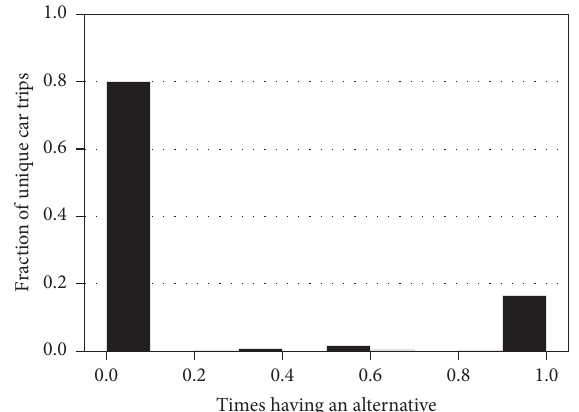
Figure 23: Consistency of having an alternative among unique car trips, illustrated by